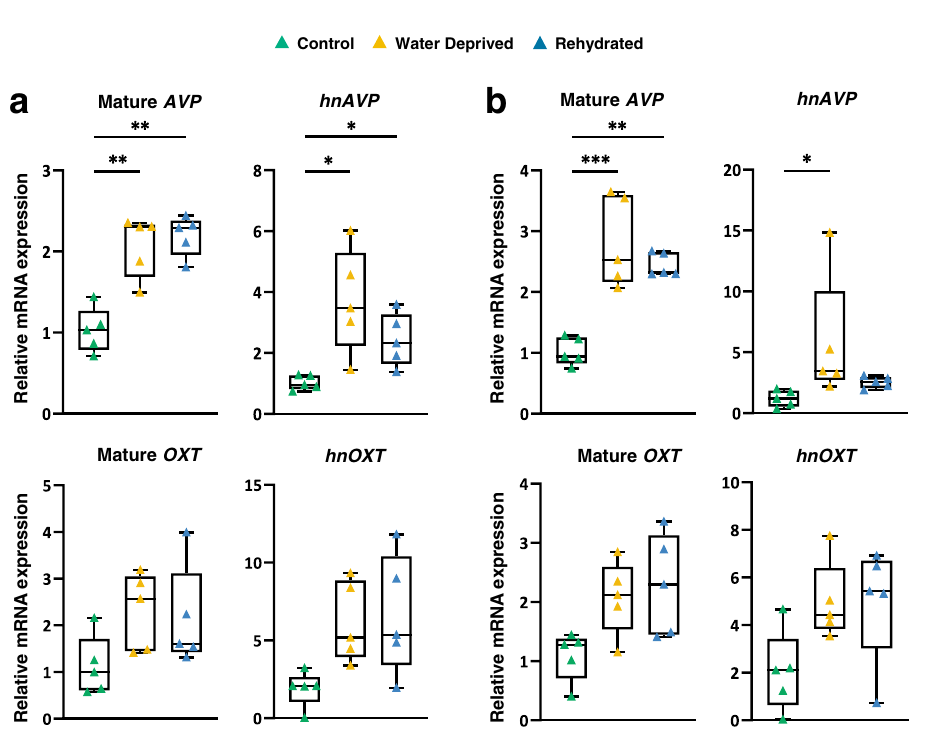
Fig. 3 Expression of the AVP and OXT genes in WD and subsequent rehydration. Relative mRNA expression levels of mature mRNA and heteronuclear RNA of AVP and OXT in rostral SON ( a ) and caudal SON ( b ) were detected by qRT-PCR. Results are illustrated by box and whisker plots with each individual value as a superimposed triangle (control: green; WD: yellow; rehydrated: blue). Whiskers represent the minimum and maximum values within a group. The median is shown as a line in the centre of the box. Data was analysed by using Brown-Forsythe and Welch one-way ANOVA with Dunnett T3 post-hoc test. *padj ≤ 0.05, **padj ≤ 0.01, ***padj ≤